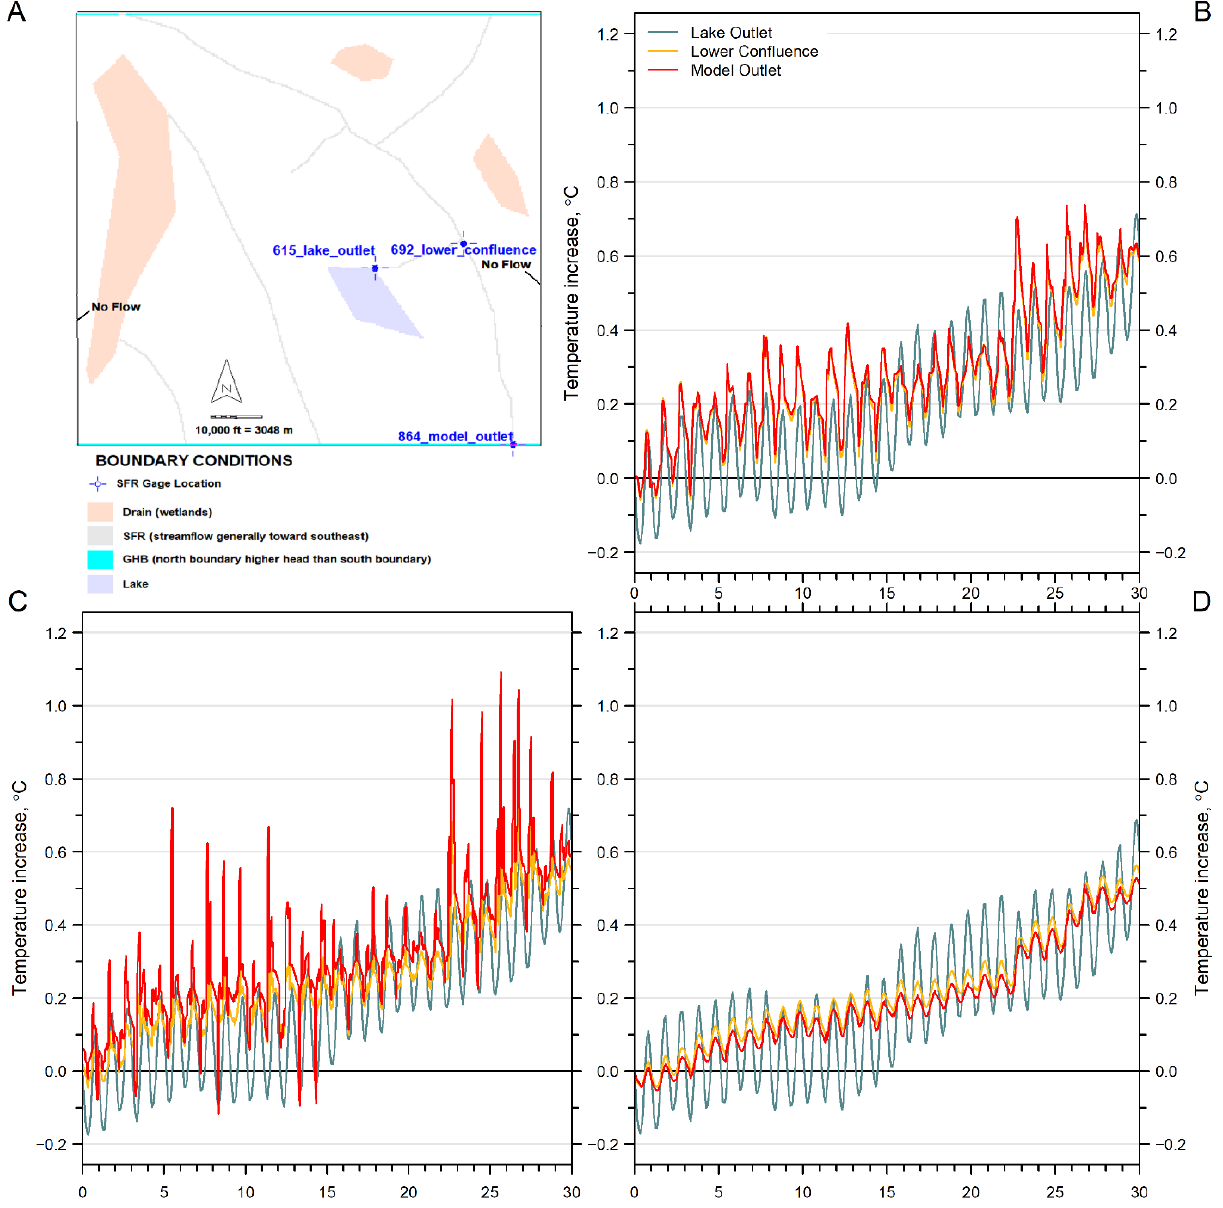
Figure 7. Simulated stream baseflow temperature response to warming ( A ) at the downgradient gage locations for the ( B ) NO_UZ_THK, ( C ) MID_UZ_THK, and ( D ) HI_UZ_THK models.